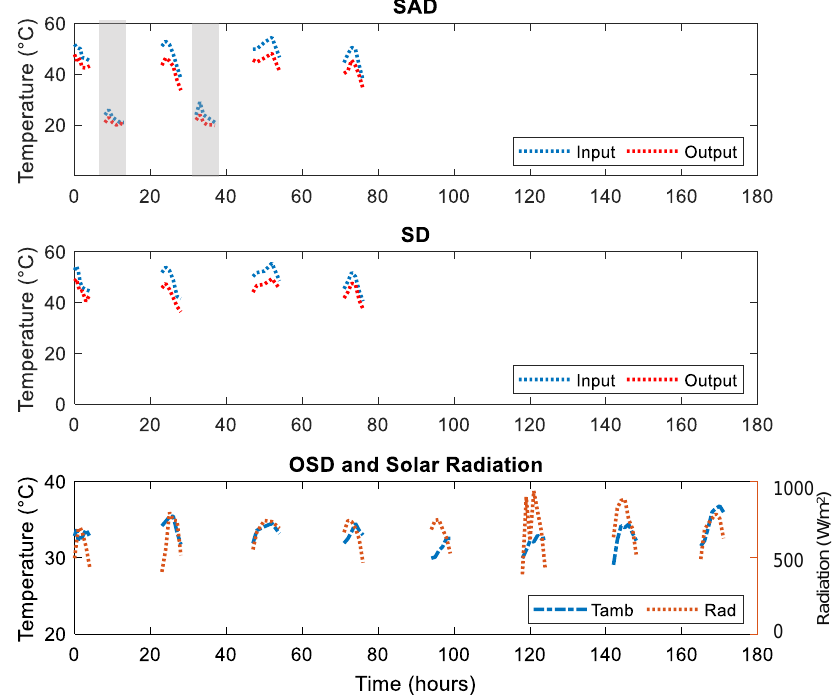
Figure 7. Drier cabinet input and output air temperatures T4 and T5 (night), T2 and T3 (day) for SAD (top graph), T2 and T3 (day) for SD (middle graph) and ambient temperature T1 for OSD (See Figure 2) and radiation (bottom graph). The grey portions represent the night drying.